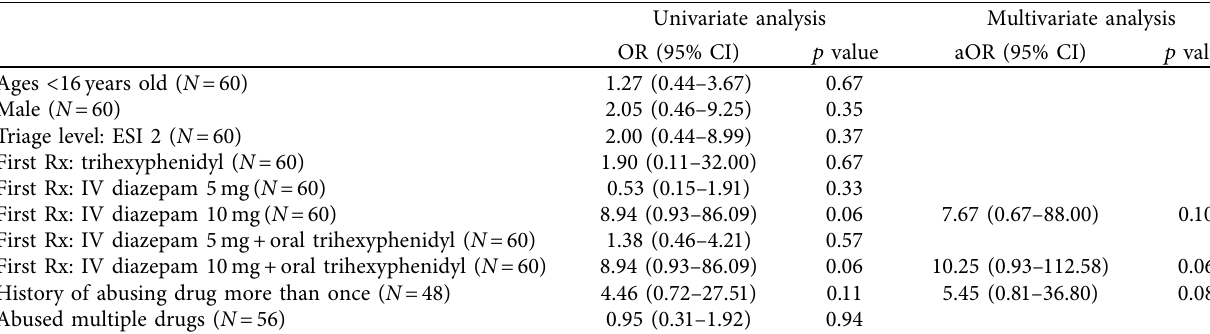
Table 6: Risk factors associated with the relapse of drug-induced acute